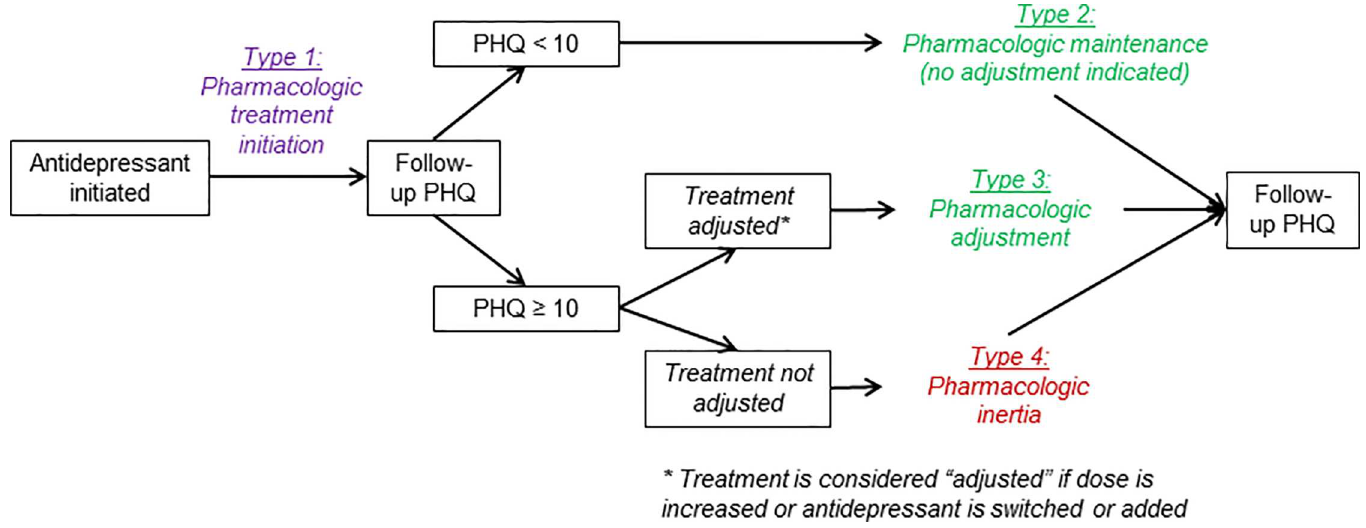
Fig 1. Conceptual frameworkfor classification of antidepressant treatment